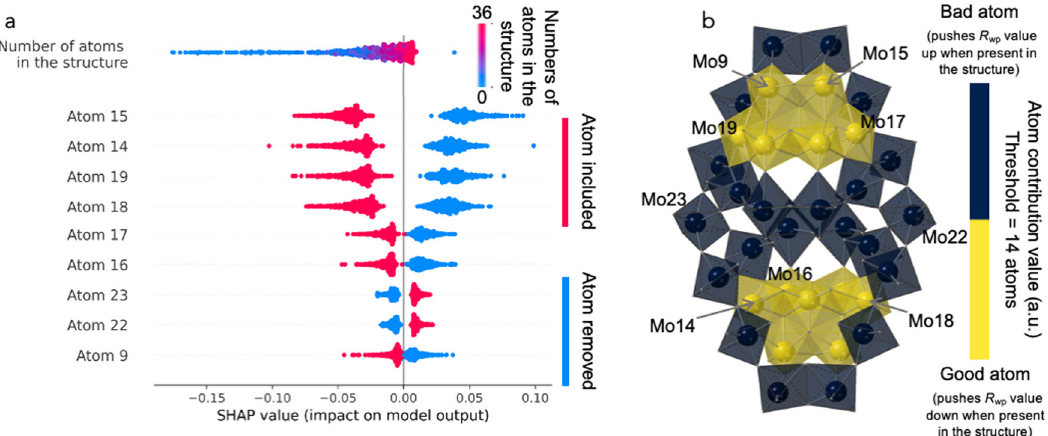
Fig. 7 Summary of the ML-MotEx analysis of experimental PDF from disordered molybdenum oxide. a Plot of the SHAP values obtained in the molybdenum oxide analysis, showing if atoms in the starting model Mo 36 O 128 are favourable for the fi t quality. For the models where the atom is not present in the model, the SHAP value is shown in blue, while it is shown in red for the atoms where it is present in the model. The SHAP values are plotted as a violin plot. An enlarged summary SHAP plot of panel a is shown in Supplementary Fig. 15. b Structural visualization of kept (yellow) and removed (black) atoms. Supplementary Fig. 3 shows a similar representation but where the atom contribution values are directly shown from a continuous colour